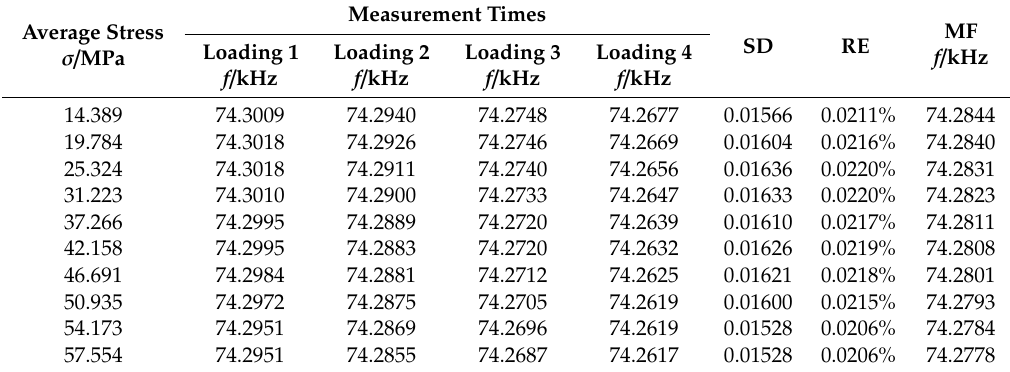
Table 2. The experimental data—1.2 m.